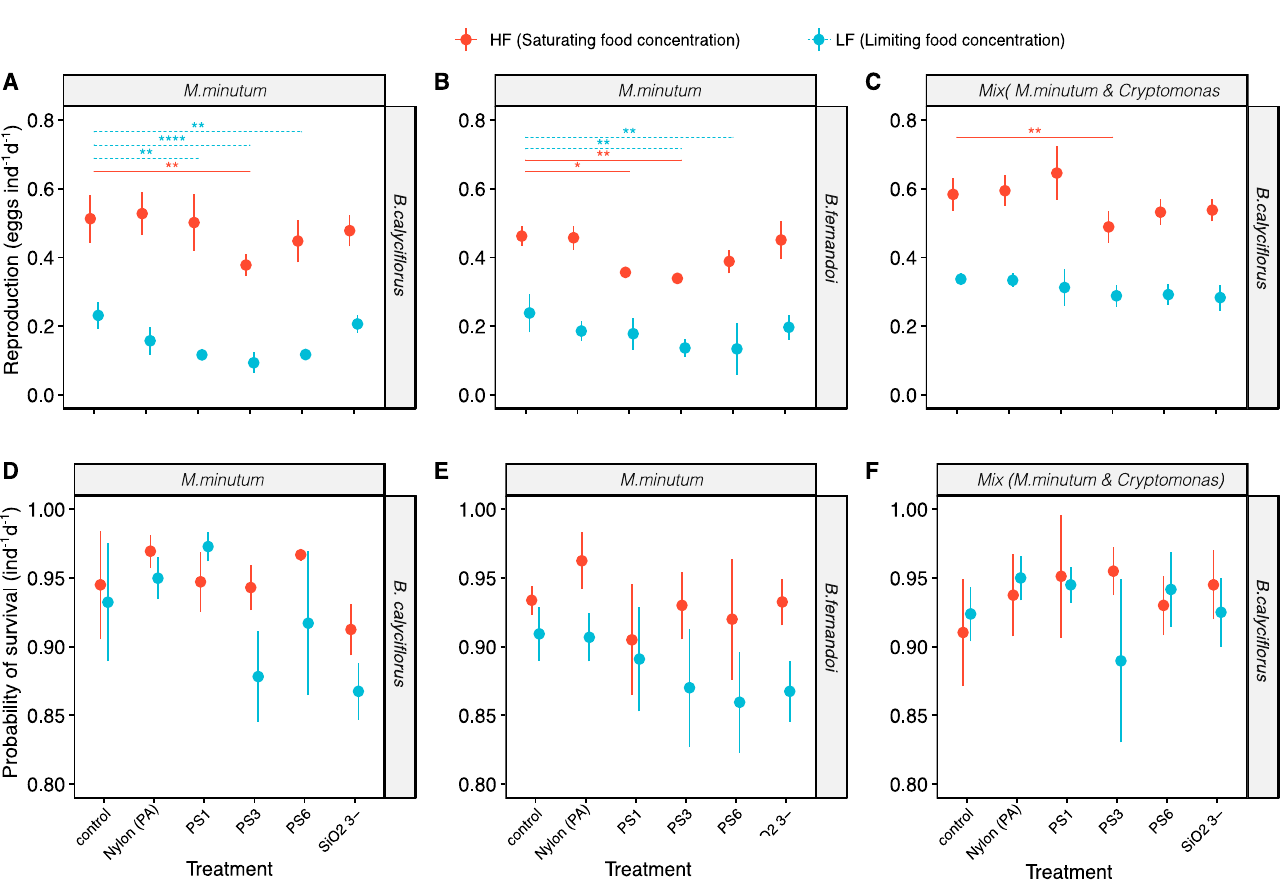
Figure 2. A − B − C egg ratio of B. calyciflorus and B. fernandoi exposed to the microbeads (mean ± SD); ( A ) egg ratio from B. calyciflorus fed on one algal species ( M. minutum ), with a statistically significant difference between the control group and the microbead treatment group; ( B ) egg ratio from B. fernandoi fed on one algal species ( M. minutum ), with a statistically significant difference between the control group and the microbead treatment group; ( C ) egg ratio from B. calyciflorus fed on mix algal diet ( M. minutum and Cryptomonas sp.), with a statistically significant difference between the control group and the microbead treatment group; D − E − F percentage of survival of B. calyciflorus and B. fernandoi exposed to the microbeads (mean ± SD); ( D ) survival of B. calyciflorus fed on one algal species ( M. minutum ), with a statistically significant difference between the control group and the microbead treatment group; ( E ) survival from B. fernandoi feeding on one algal specie ( M. minutum ); ( F ) survival from B. calyciflorus fed on mix algal diet ( M. minutum and Cryptomonas sp.), with a statistically significant difference between the control group and the microbead treatment group.